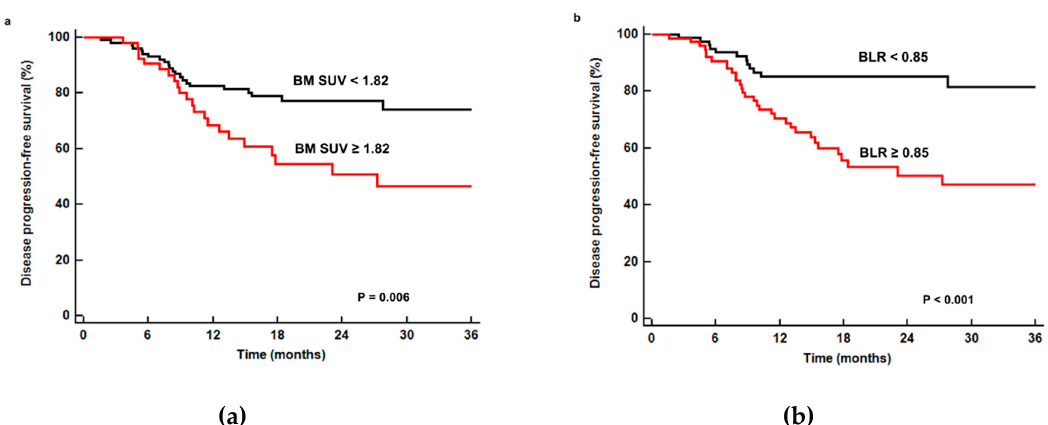
Table 4. Univariate and multivariate analyses of distant failure-free survival. Univariate Analysis Multivariate Analysis Variables Figure 3. Cumulative disease progression-free survival curves according to BM SUV ( a ) and BLR ( b ). Patients with low BM SUV ( < 1.82) and BLR ( < 0.85) showed significantly better disease progression-free survival ( p = 0.006 for BM SUV and p < 0.001 for BLR) than those with high BM SUV ( ≥ 1.82) and BLR ( ≥ 0.85), respectively.